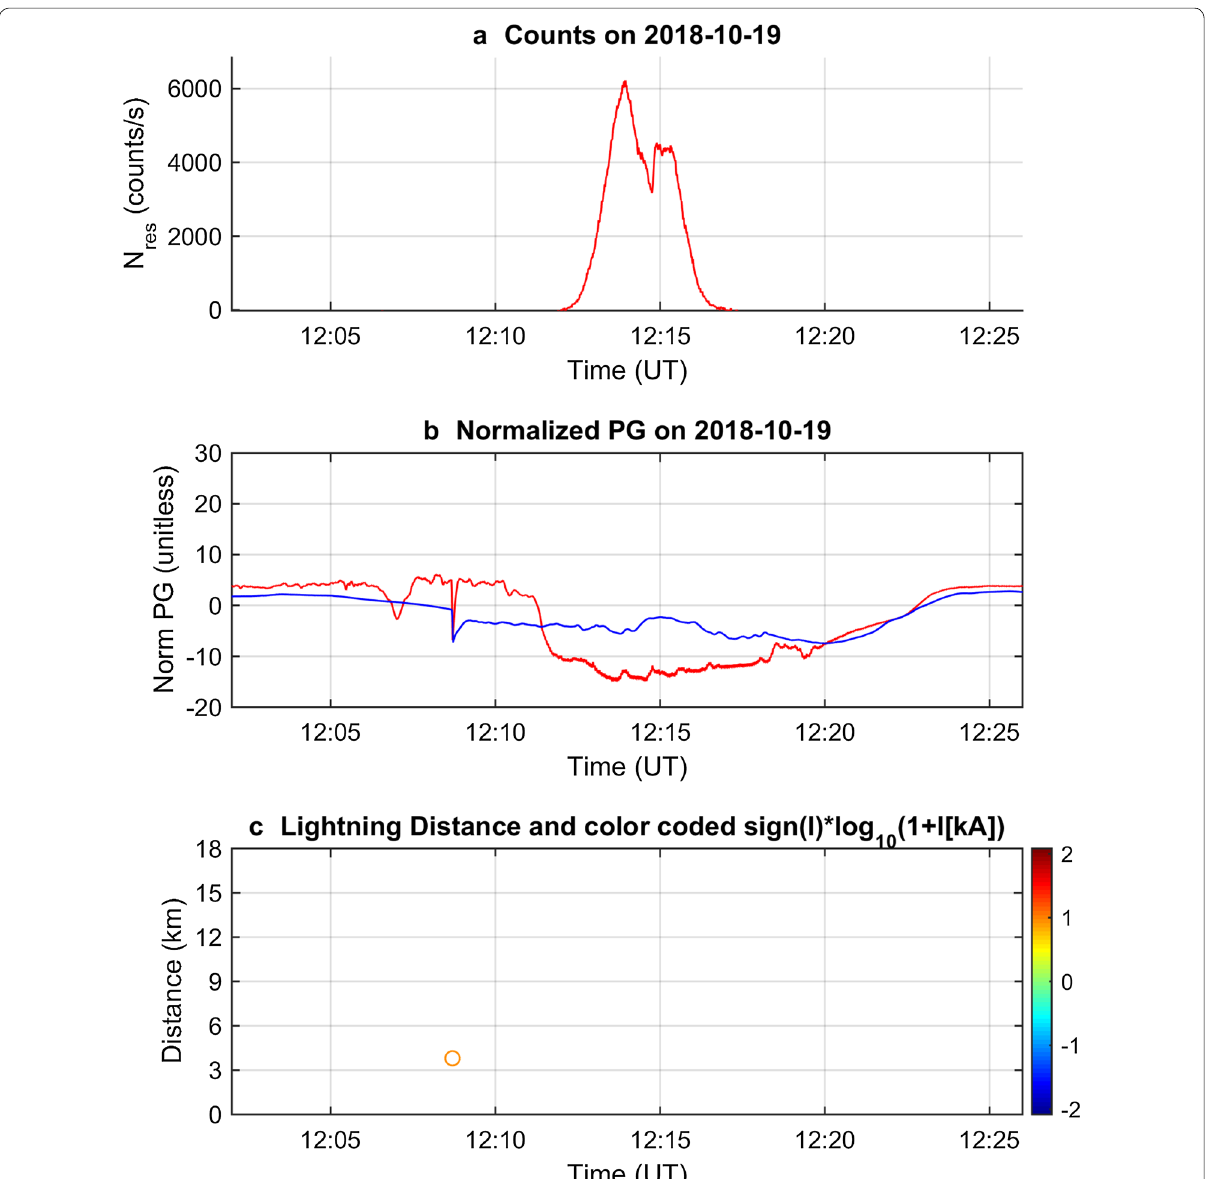
Fig. 7 Strong event recorded on 19 October 2018 around 12:14 UT. a Residual counts at Lomnicky peak by red. b Normalized PG at Lomnicky peak (red) and Skalnate Pleso (blue). c Lightning distances from Lomnicky peak as recorded by EUCLID lightning detection network; CG discharges are by diamonds, IC by circles, peak current I is color-coded; the color approximately corresponds to the common logarithm of the peak current in kA, sign of the current is